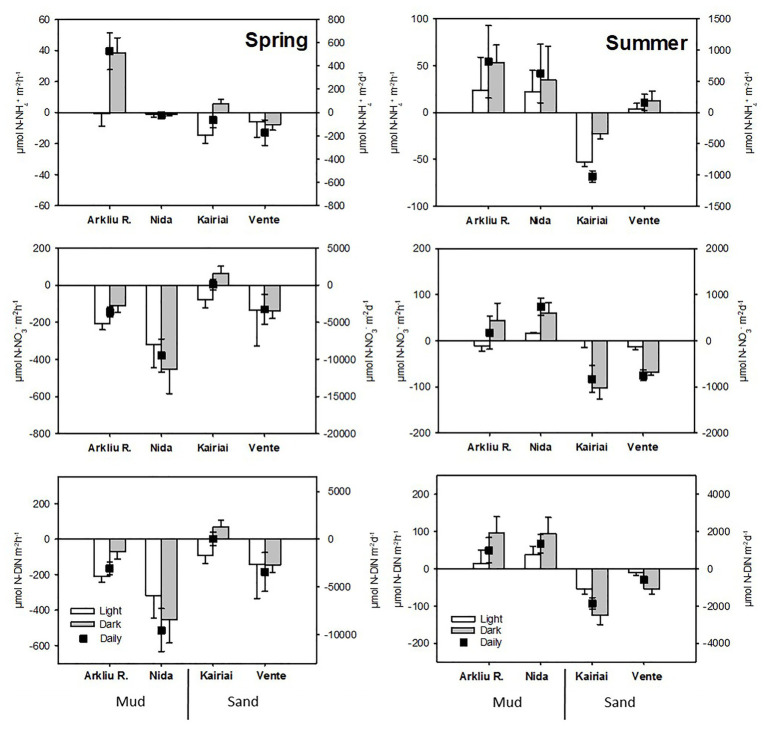
Light, dark, and daily flux across the sediment-water interface of NH4
+, NO3
−, and DIN (average ± standard error, n = 5) measured in spring and summer 2009 at the four sampling sites. Note different scales on the y-axes.